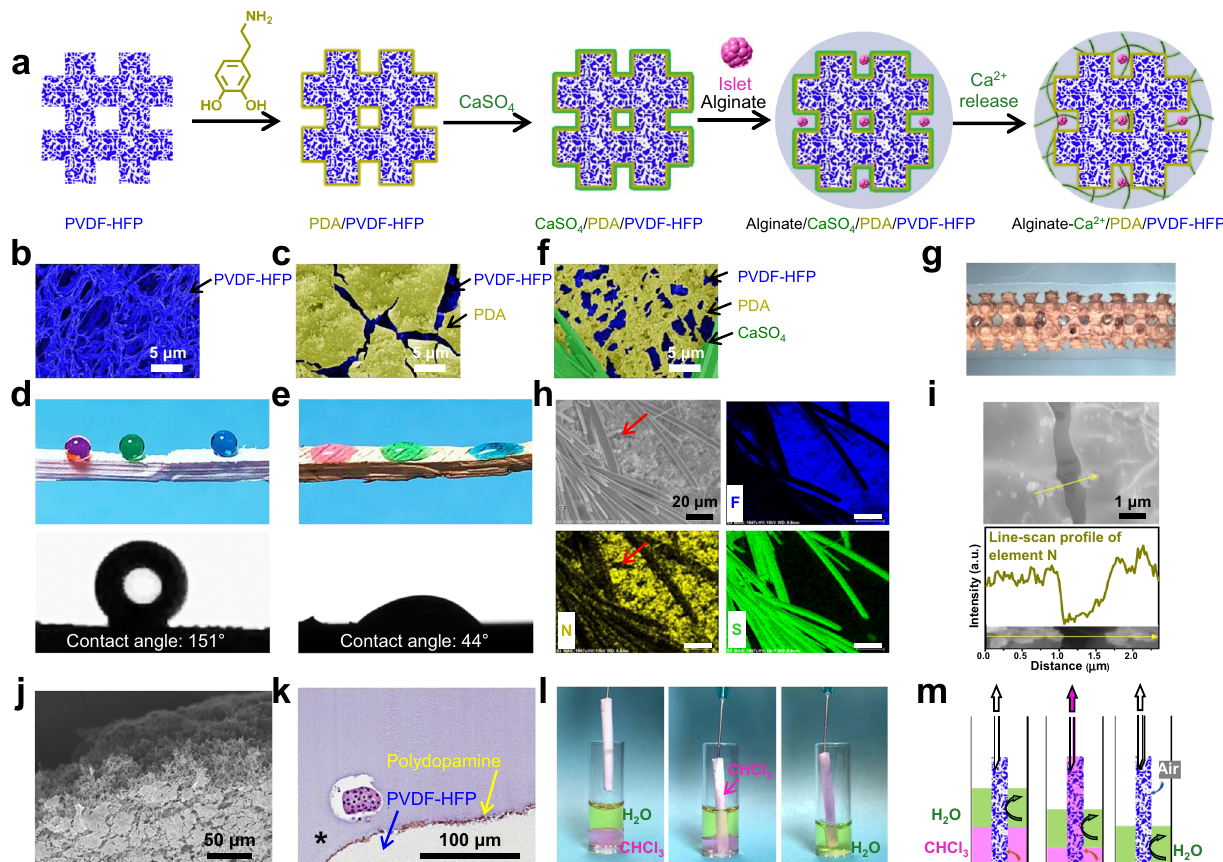
Fig. 2 Fabrication and characterizations of the SONIC device. a Schematic illustration of the device fabrication (side view). b , c False-colored SEM images of the SONIC scaffold ( b ) and polydopamine-coated SONIC scaffold ( c ). One representative of 3 independent experiments is shown. d , e Digital images of water droplets (colored with food dye) and contact angle goniometer-captured images of a water droplet on a rectangular prism SONIC scaffold before ( d ) and after ( e ) polydopamine modi fi cation. f A false-colored SEM image of the polydopamine-coated SONIC scaffold with deposited CaSO 4 crystals. One representative of 3 independent experiments is shown. g Stereo microscope image of the SONIC device (top view). h SEM/EDS elemental mapping of F, N, and S on a polydopamine-coated SONIC scaffold with deposited CaSO 4 crystals. The red arrows indicate the lack of polydopamine at a coating crack location. One representative of 3 independent experiments is shown. i SEM image of the polydopamine-coated SONIC scaffold and the corresponding element N distribution pro fi le across a polydopamine coating crack. One representative of 3 independent experiments is shown. j SEM image of the cross- sectional polydopamine-modi fi ed SONIC scaffold, showing no polydopamine inside the scaffold. One representative of 3 independent experiments is shown. k An H&E staining slice of an islet encapsulation device showing the polydopamine located at the interface between the SONIC scaffold and alginate hydrogel. One representative of 10 replicates is shown. l Captured images during the perfusion test using a cylindrical SONIC scaffold. A pump- connected needle was inserted into one end of a cylindrical SONIC scaffold, and the other end of the SONIC scaffold was immersed into a vial containing water phase (top, colored with green food dye) and chloroform phase (bottom, colored by Nile Red dye). m Schematics representing the distribution of water and chloroform during the perfusion